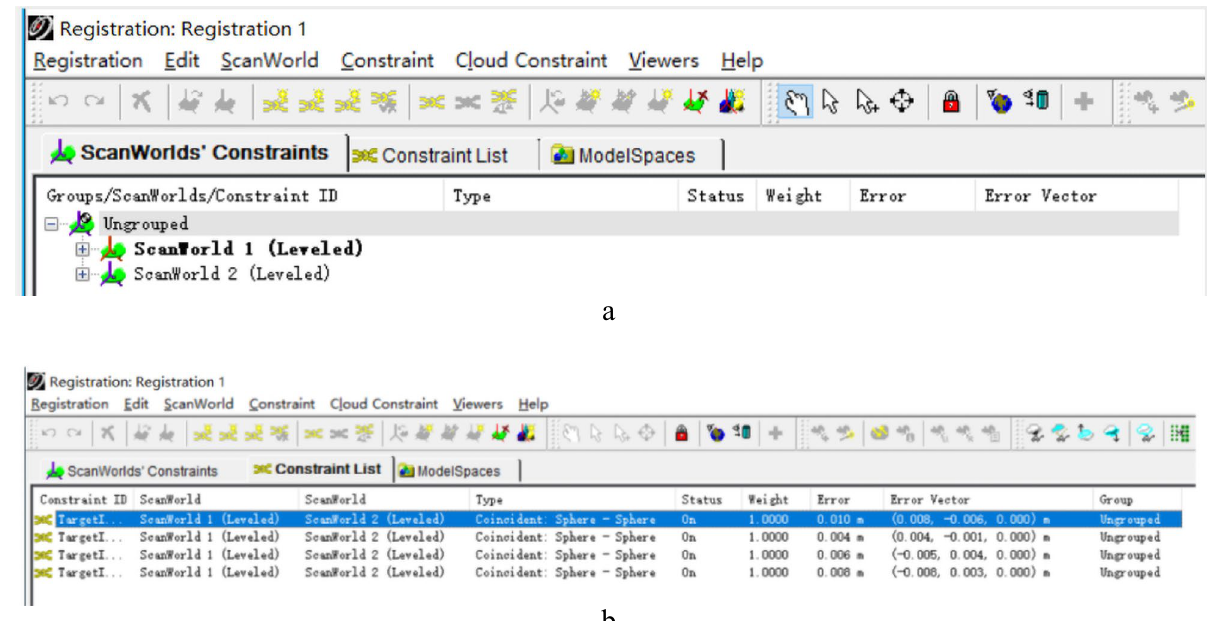
Figure 6. Stitching of point cloud data. ( a ) The setting of the main station and auxiliary station. ( b ) Common feature point error